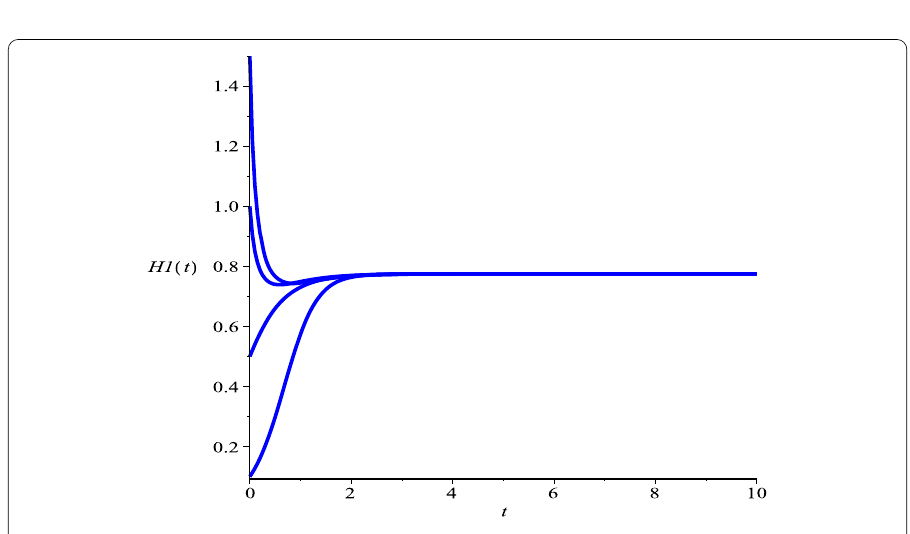
Figure 4 Dynamic behaviors of the strong partners in system (5.3). The initial conditions ( H 1 (0), H 2 (0), P (0)) = (1,2,0.7),(1.5,1,0.3),(0.5,0.2,0.1), and (0.1,0.1,2),